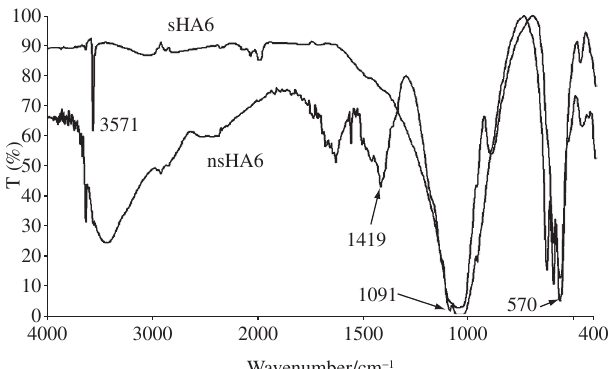
Figure 7. FTIR spectra of nsHA6 and sHA6.